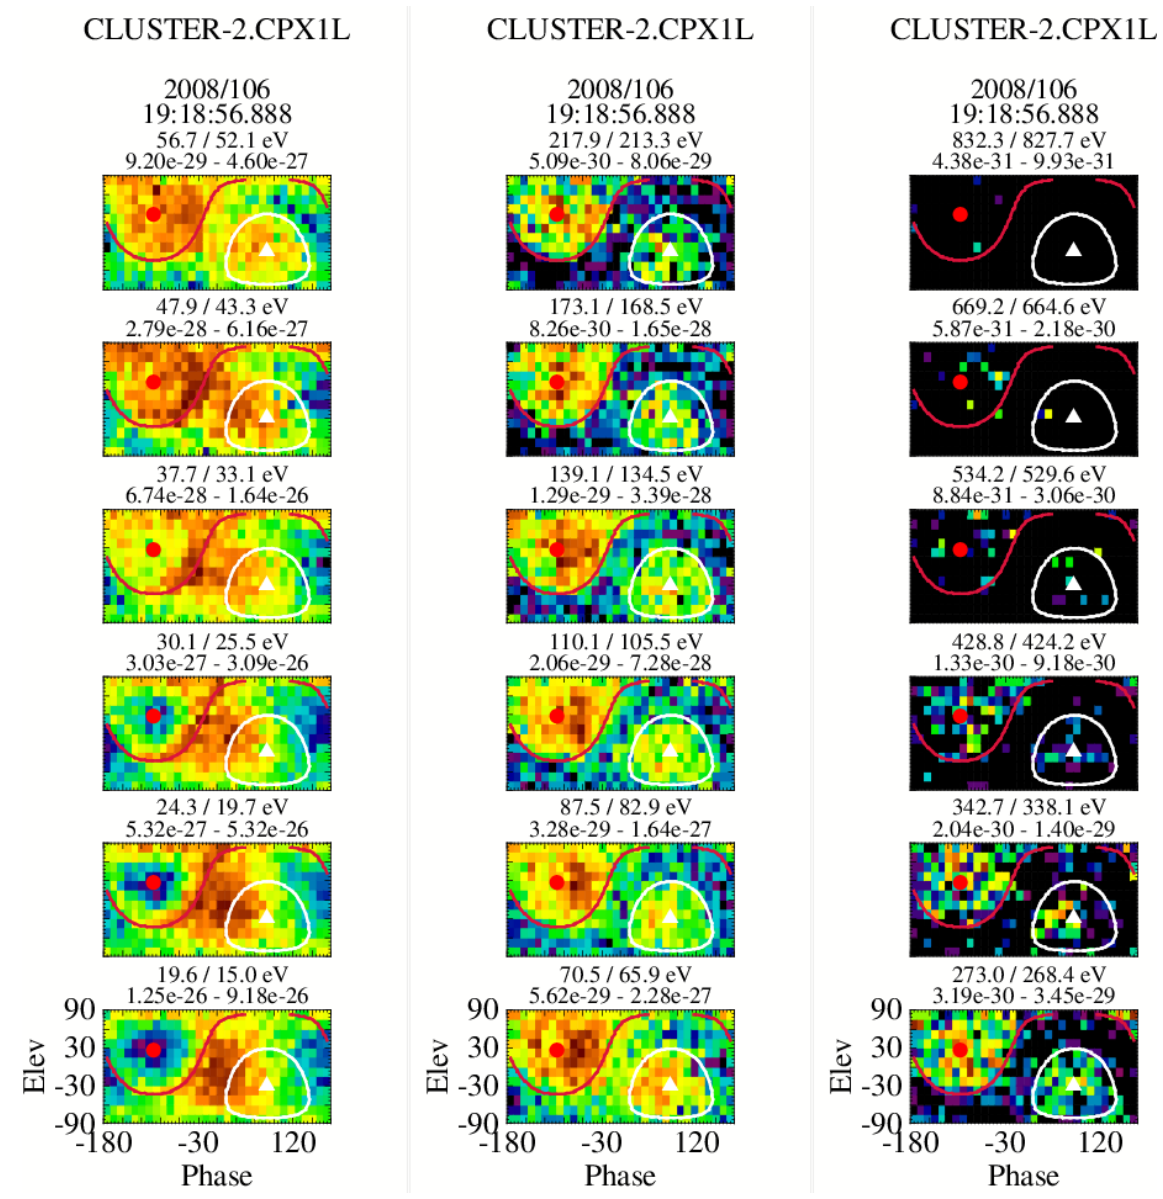
Figure 12. A set of φ – θ plots showing each energy step from 15.8 to 669.2eV from a single eVDF in the foreshock. The white and red traces are lines of constant pitch angles (125 and 70 ◦ ) and are shown solely to indicate the areas where the strahl (white) and return electrons (red) might be expected to be found. The presence of either population may not exist at any given energy. The solid triangle and dot in the plots are the projections of the tail and head of the magnetic field